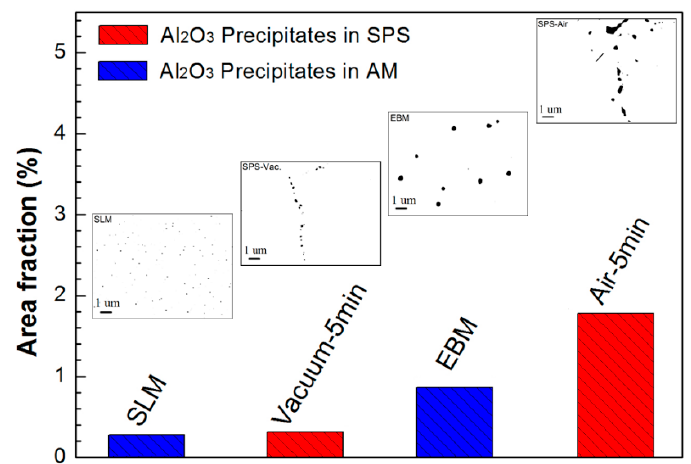
Figure 11. The content of Al 2 O 3 precipitates formed in AM and SPS specimens, in which each value was calculated with ImageJ software.